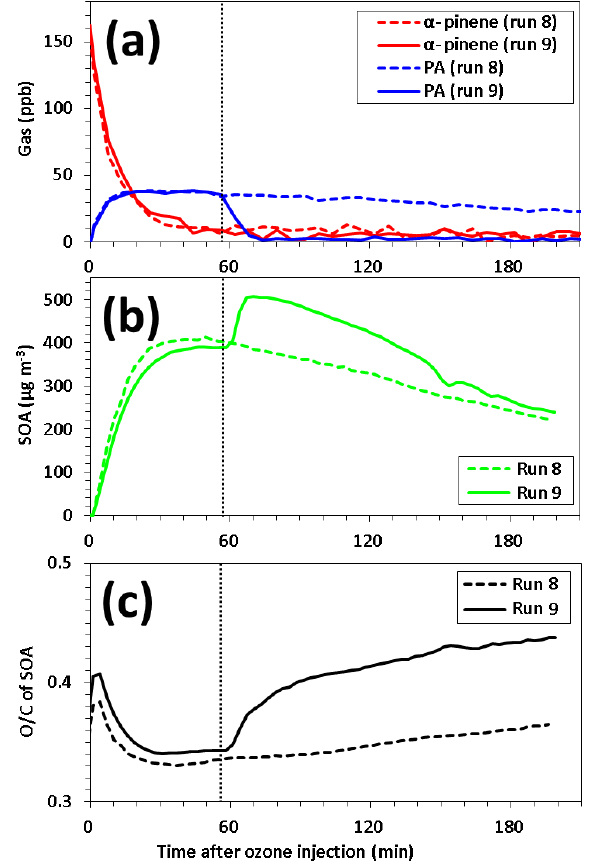
Figure 1. Time series of (a) FT-IR gas concentrations, (b) AMS SOA concentration, and (c) AMS SOA O / C ratio during a simple ozonolysis experiment (run 8) and aging experiment, in which SOA formed from ozonolysis was exposed to OH radicals (run